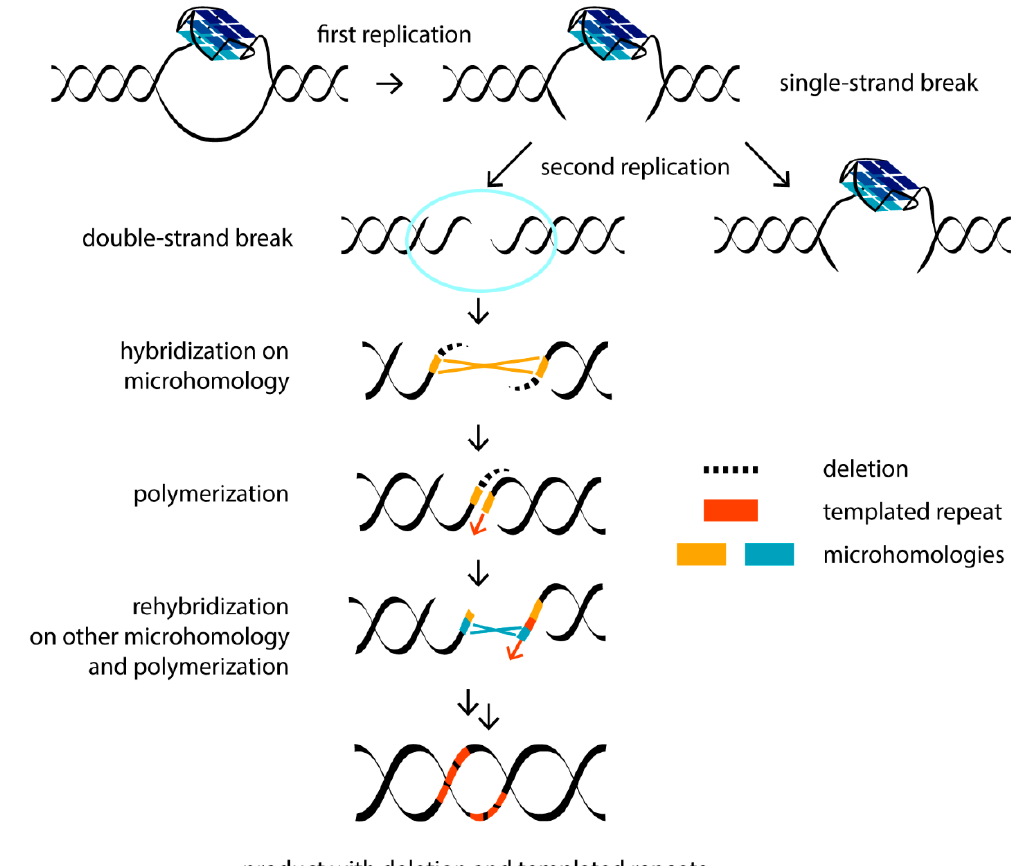
Figure 2. Scheme of G4-mediated genesis of DSBs after the second round of replication and subsequent DSB repair by the TMEJ mechanism with the formation of typical mutational patterns. Hybridization based on microhomology (in orange) and DNA synthesis by DNA Pol θ results in the deletion of sites external to microhomology (dashed line). Switching the template to another microhomologous sequence (in blue) leads to a Pol θ -mediated sequence insertion adjacent to the microhomology (in red). Several template switches can result in more reinsertions.